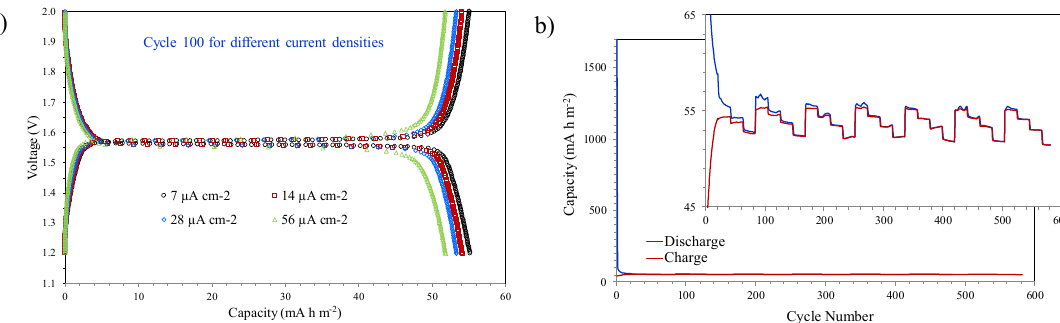
Figure 9. Galvanostatic discharge-charge test at different current densities (7, 14, 28, 56 µA cm −2 ) of a sample treated at 650 °C: ( a ) capacities vs. voltage curves of the cycle 100 for different current densities, and ( b ) cycle number vs. capacities curves with 20 cycles at each current density.